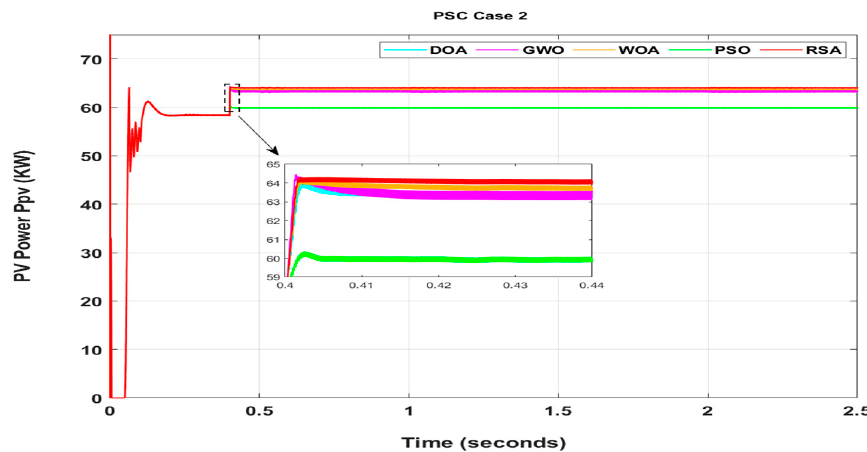
Figure 8. PV output power under PSC case 2.